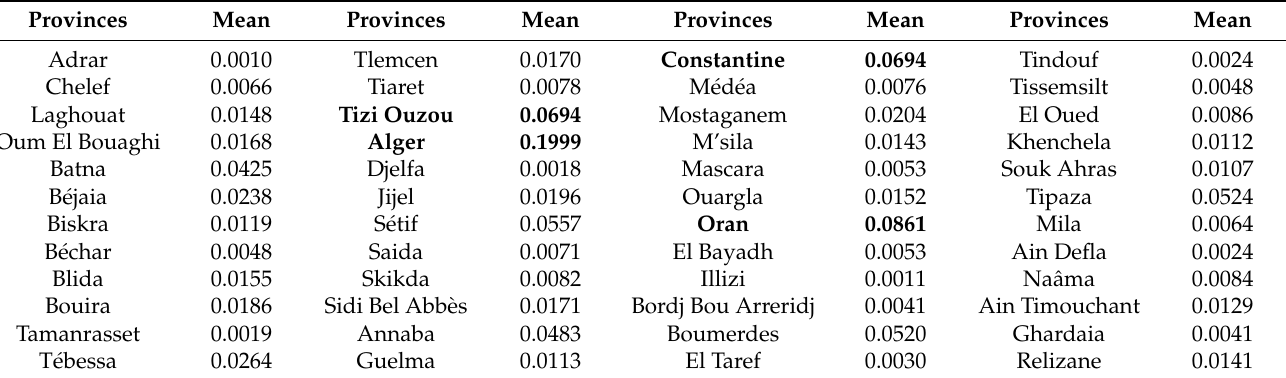
Table 2. Provincial COVID-19 infection rates 1